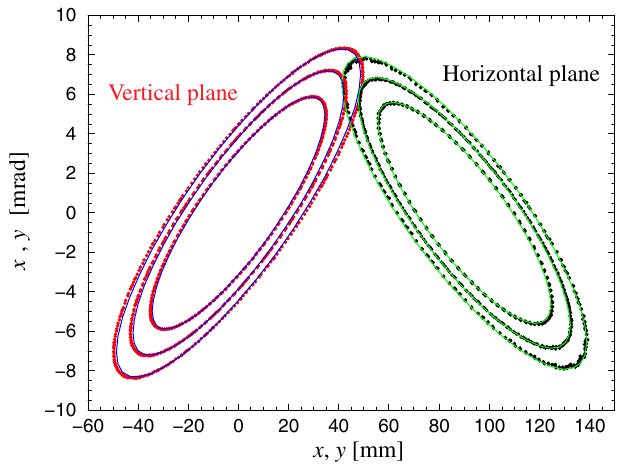
FIG. 6. (Color) Poincare´ map at the stripping foil between SB2 and SB3 ( s (cid:4) 82 : 113 m ) during 300 turns with shift-bump magnets in operation. Lines correspond to the bare ring parame- ters without any bump